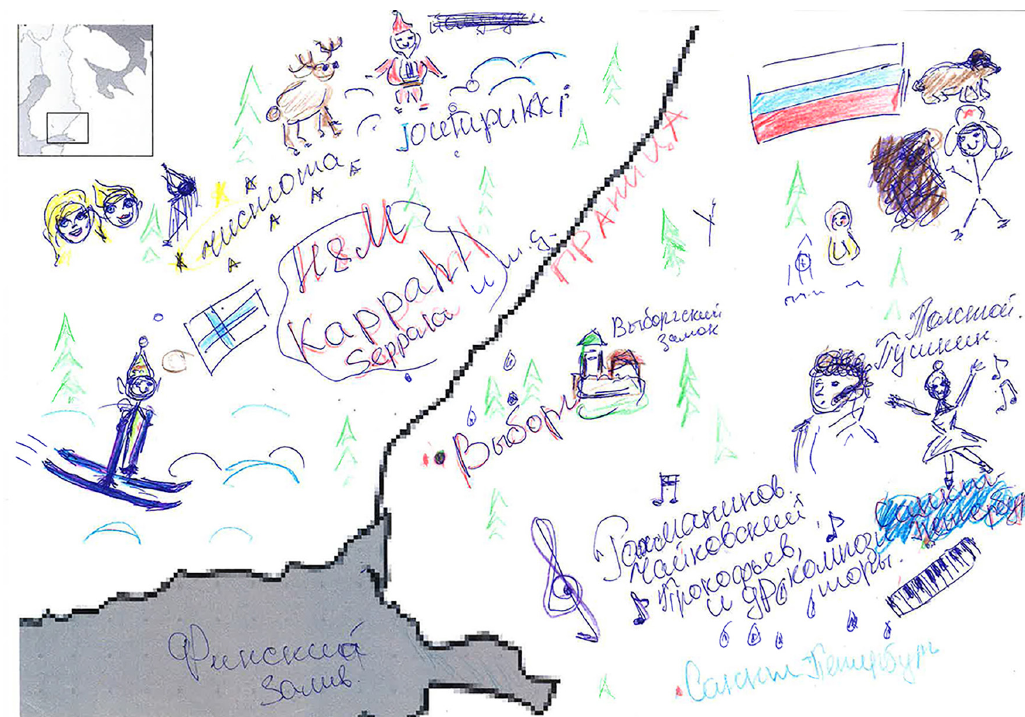
Fig. 4 . An eight-class Russian girl uses traditional symbols and references to Russian classical culture to describe the Russian side of the border, but on the Finnish side she mentions (besides stereotypical images) clothing stores, which indicate her own experiences of shopping in Finnish border